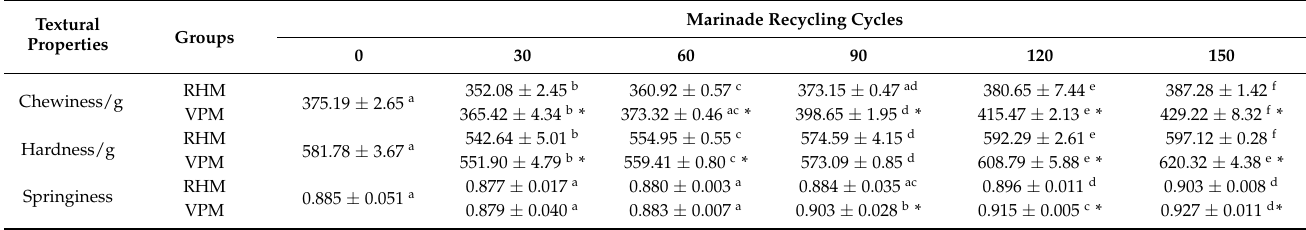
Table 1. Effects of different marinating methods and marinade recycling cycles on the textural characteristics of